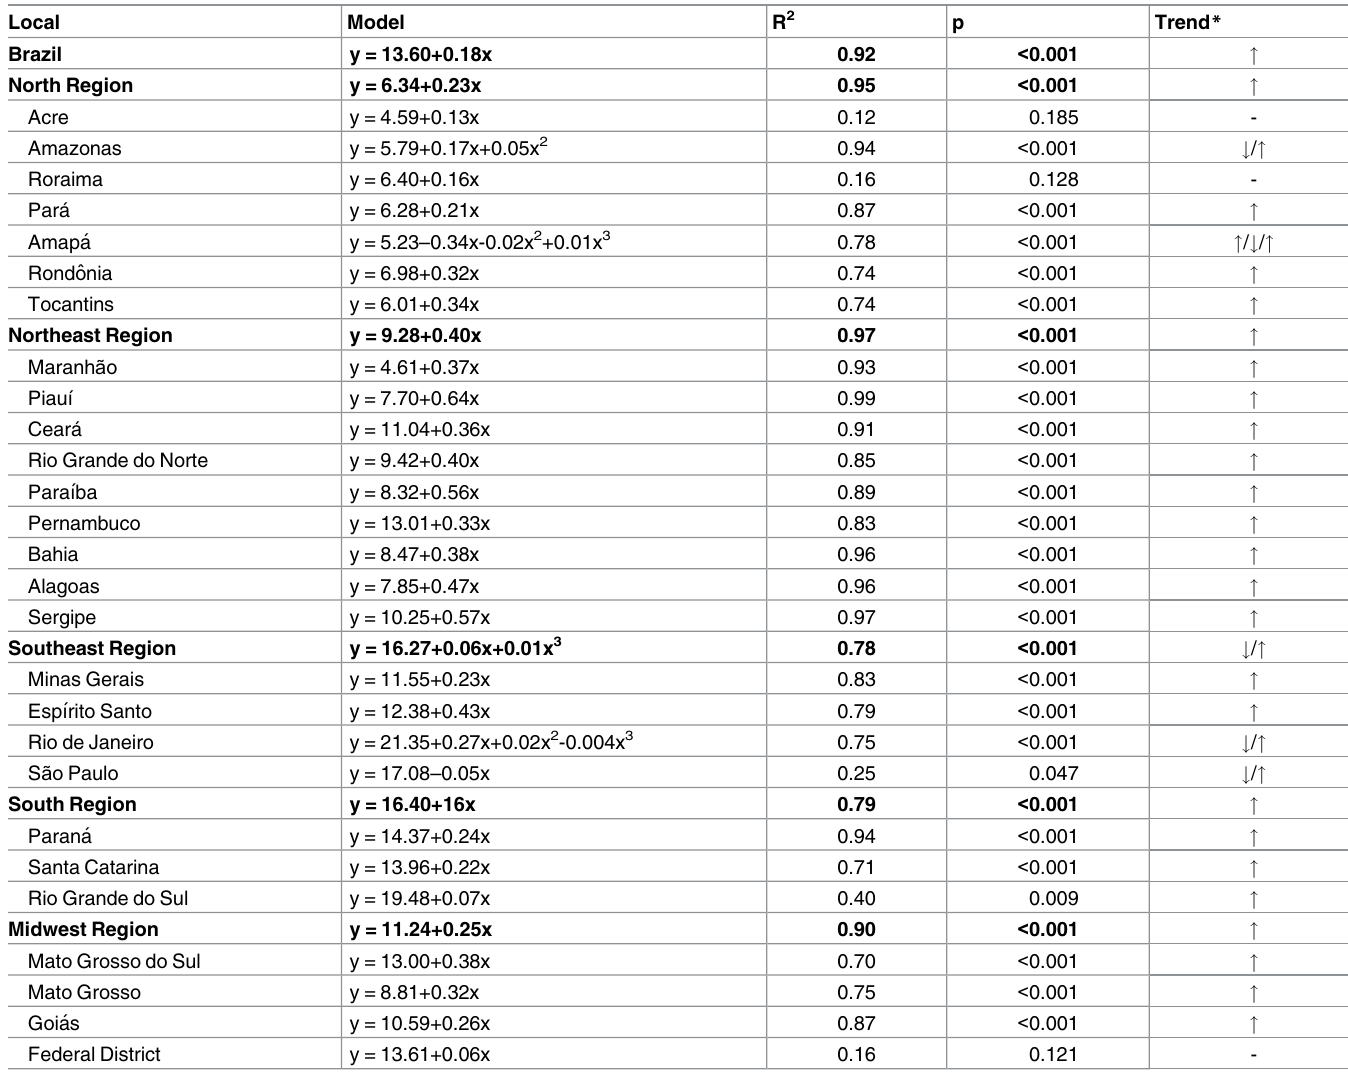
Table 1. Trend models of mortality rates from breast cancer. Brazil,